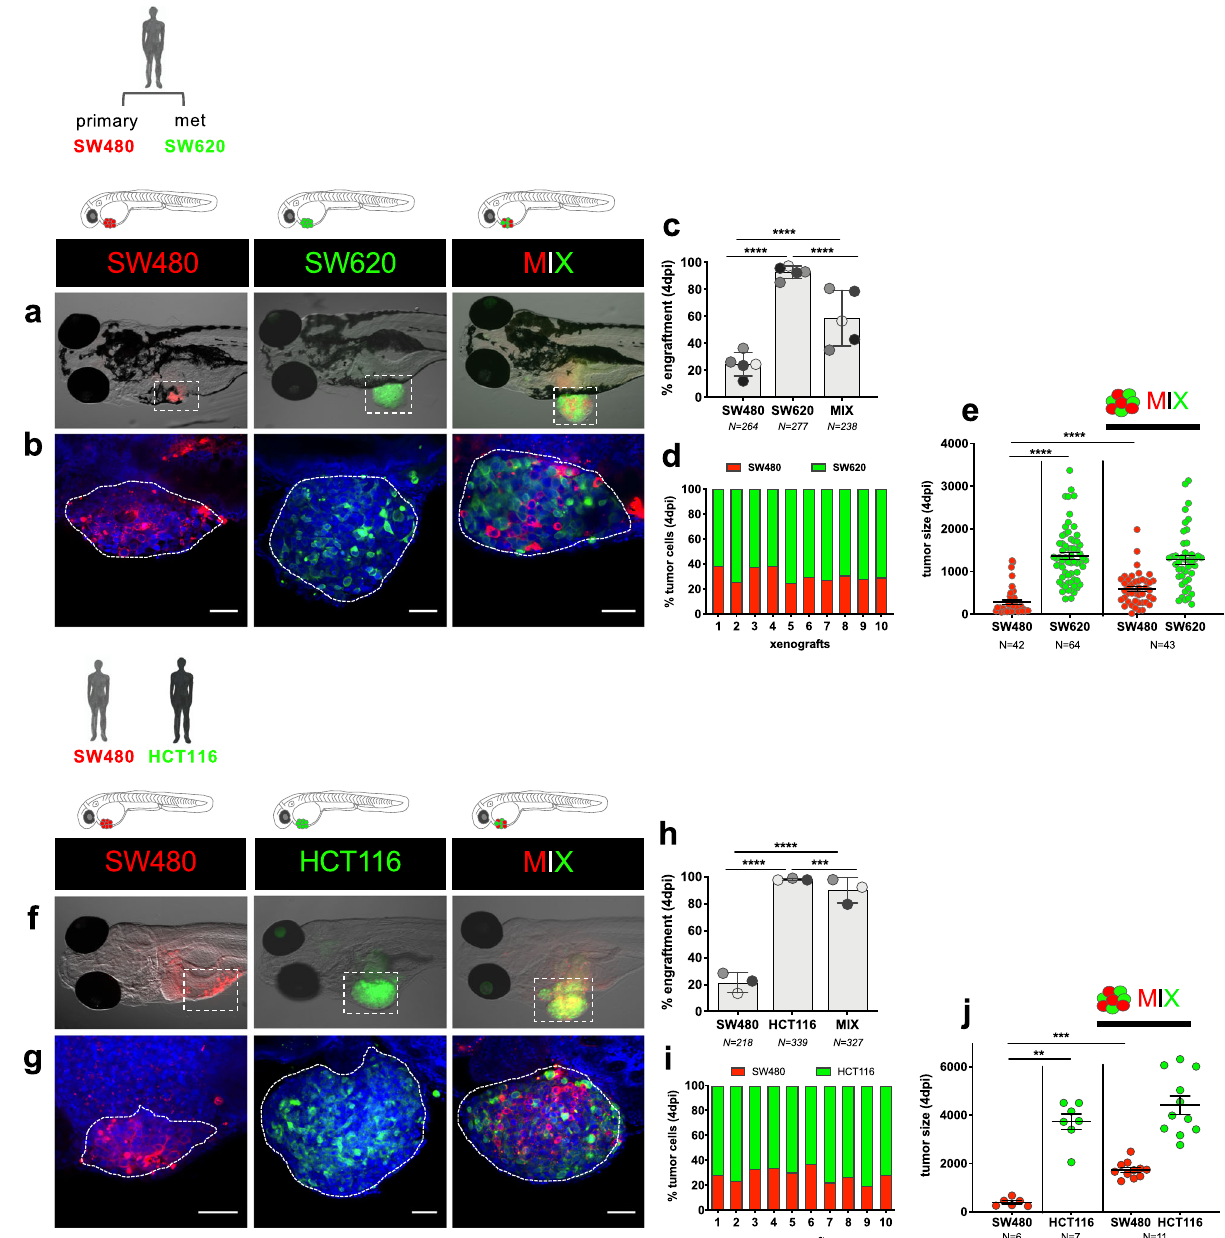
Fig. 2 Progressor tumor cells are able to protect regressors from being cleared. Tumor cells were labeled with lipophilic dyes and injected into the PVS of 2dpf zebra fi sh embryos. a , b Representative images of SW480 (in red), SW620 (in green), and MIX (1:1) polyclonal zebra fi sh xenografts at 4 dpi. a Fluorescence stereoscope images. b Confocal images. c Engraftment quanti fi cation at 4 dpi (Fisher exact test **** P < 0.0001). Graph shows the mean ± S. D. Each dot represents one independent experiments (5), and each set of independent experiments is represented in a different gray color. d Representative quanti fi cation of the proportions of each clone within each xenograft ( N = 10) from four independent experiment. e Quanti fi cation of tumor size (no. of tumor cells) at 4 dpi (unpaired two-sided Mann – Whitney test **** P < 0.0001). Graph shows the mean ± SEM from four independent experiments, each dot represents one xenograft. f , g Representative images of SW480 (in red), HCT116 (in green), and MIX (1:1) zebra fi sh xenografts at 4 dpi. f Fluorescence stereoscope images. g Confocal images. h Engraftment quanti fi cation at 4 dpi (Fisher exact test **** P < 0.0001, *** P = 0.0005). Graph shows the mean ± S.D. Each dot represents one independent experiment ( N = 3), and each set of independent experiments is in a different gray color. i Representative quanti fi cation of the cell proportions of each clone within each xenograft ( N = 10) from one independent experiment. j Quanti fi cation of tumor size (no. of tumor cells) at 4 dpi (unpaired two-sided Mann – Whitney test ** P = 0.0012, Cohen ’ s D g = 4.88; *** P = 0.0002, Cohen ’ s D g = 4.32). Graph shows the mean ± SEM from one independent experiment, each dot represents one xenograft. Scale bars: 50 μ m. Dashed lines encircle tumor areas. Nuclei are stained with DAPI (blue). N is depicted in the charts. Source data are provided as a Source data fi le.